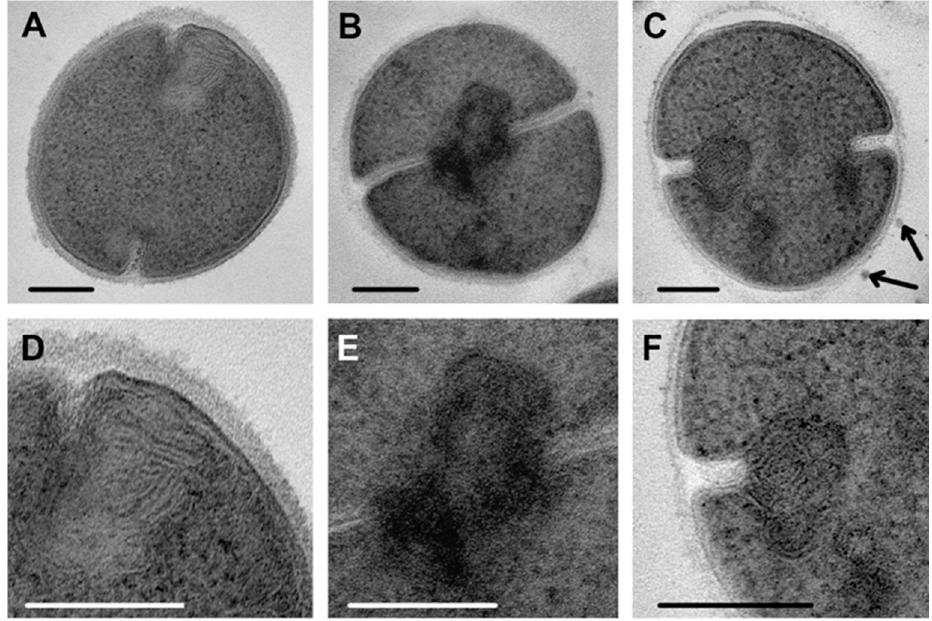
Figure 8. Multimembrane structures located in areas of septa formation in S. aureus cells incubated with chlorhexidine for 15 min ( A ); 1 h ( B ) and 4 h ( C ). ( D – F )—enlarged fragments of images ( A – C ). Arrow shows MV. TEM of ultrathin sections. Scale bars correspond to 200 nm.